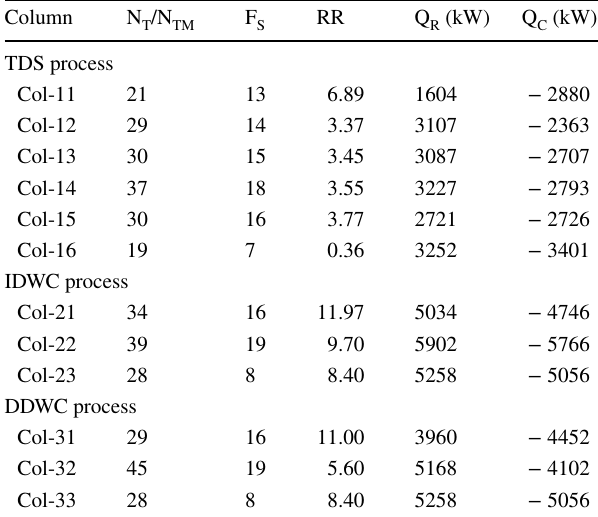
Table 1 Summary of optimal reboiler duty of three F–T synthetic oil separation processes